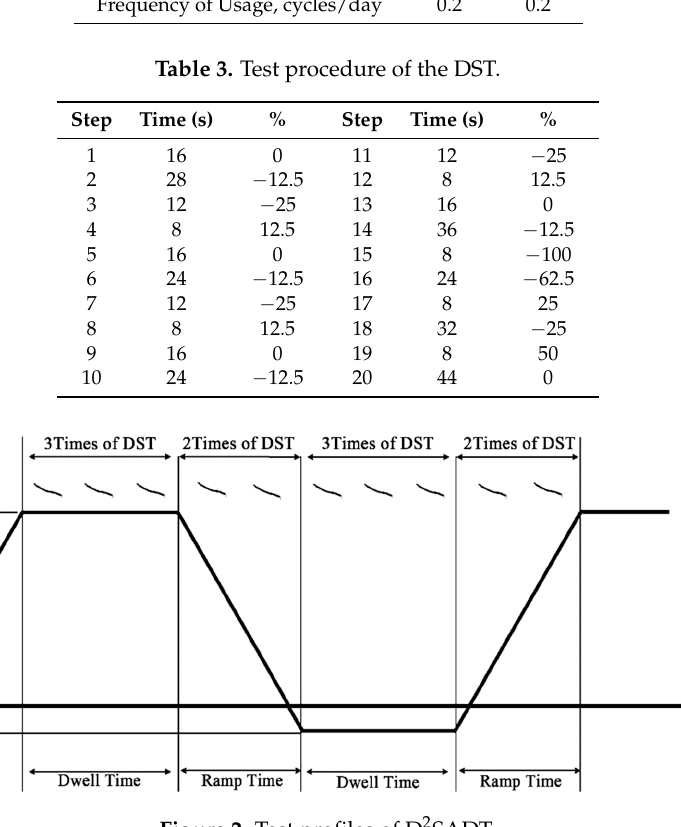
Table 1. Some specifications of the test battery.